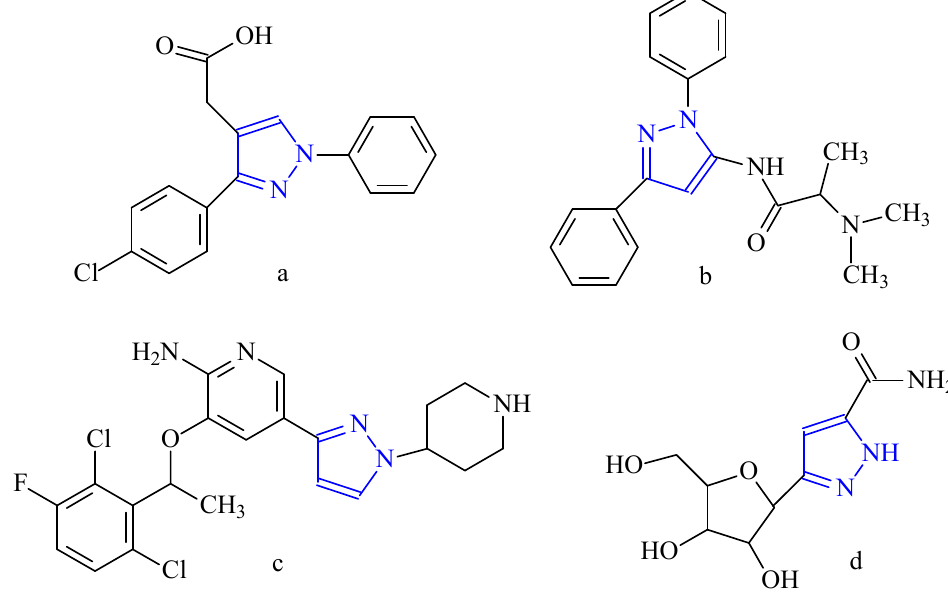
Figure 1. Drugs containing pyrazole ring.